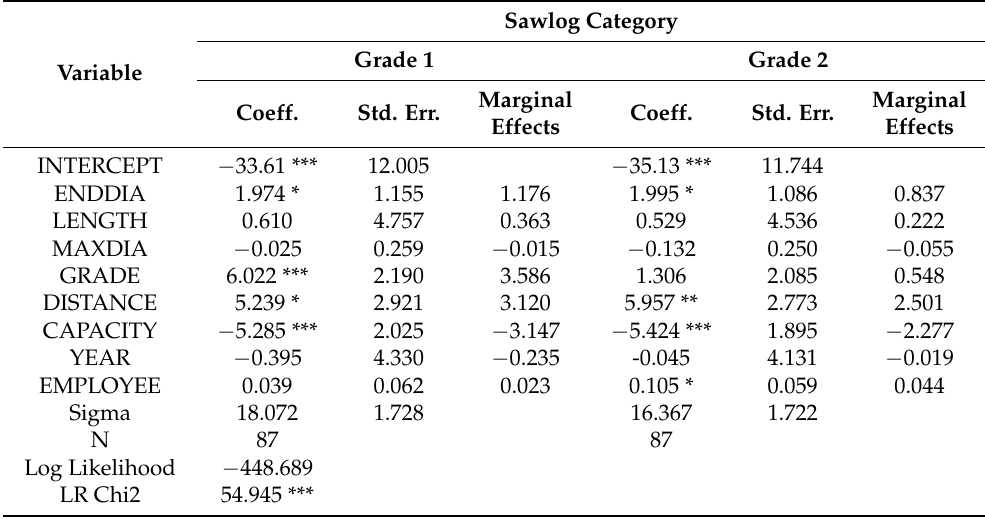
EMPLOYEE 0.039 0.062 0.023 0.105 * 87